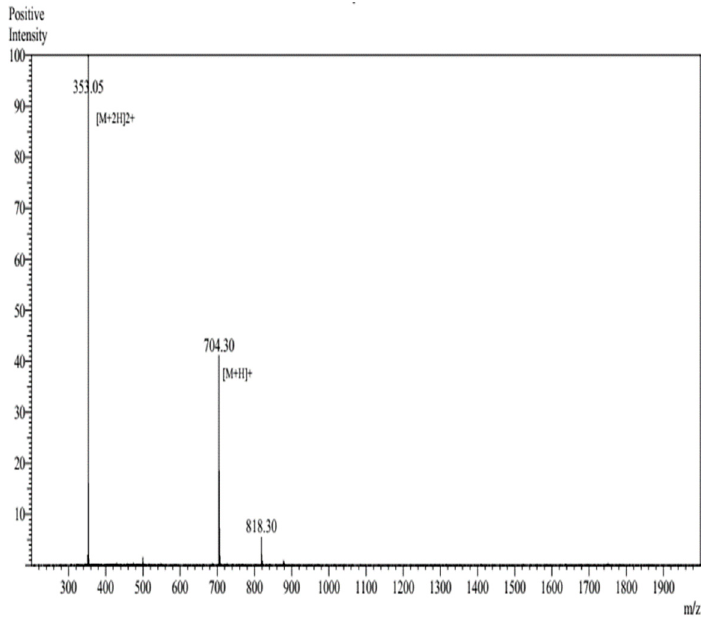
Figure A2. HPLC image of LA ‐ RWR.